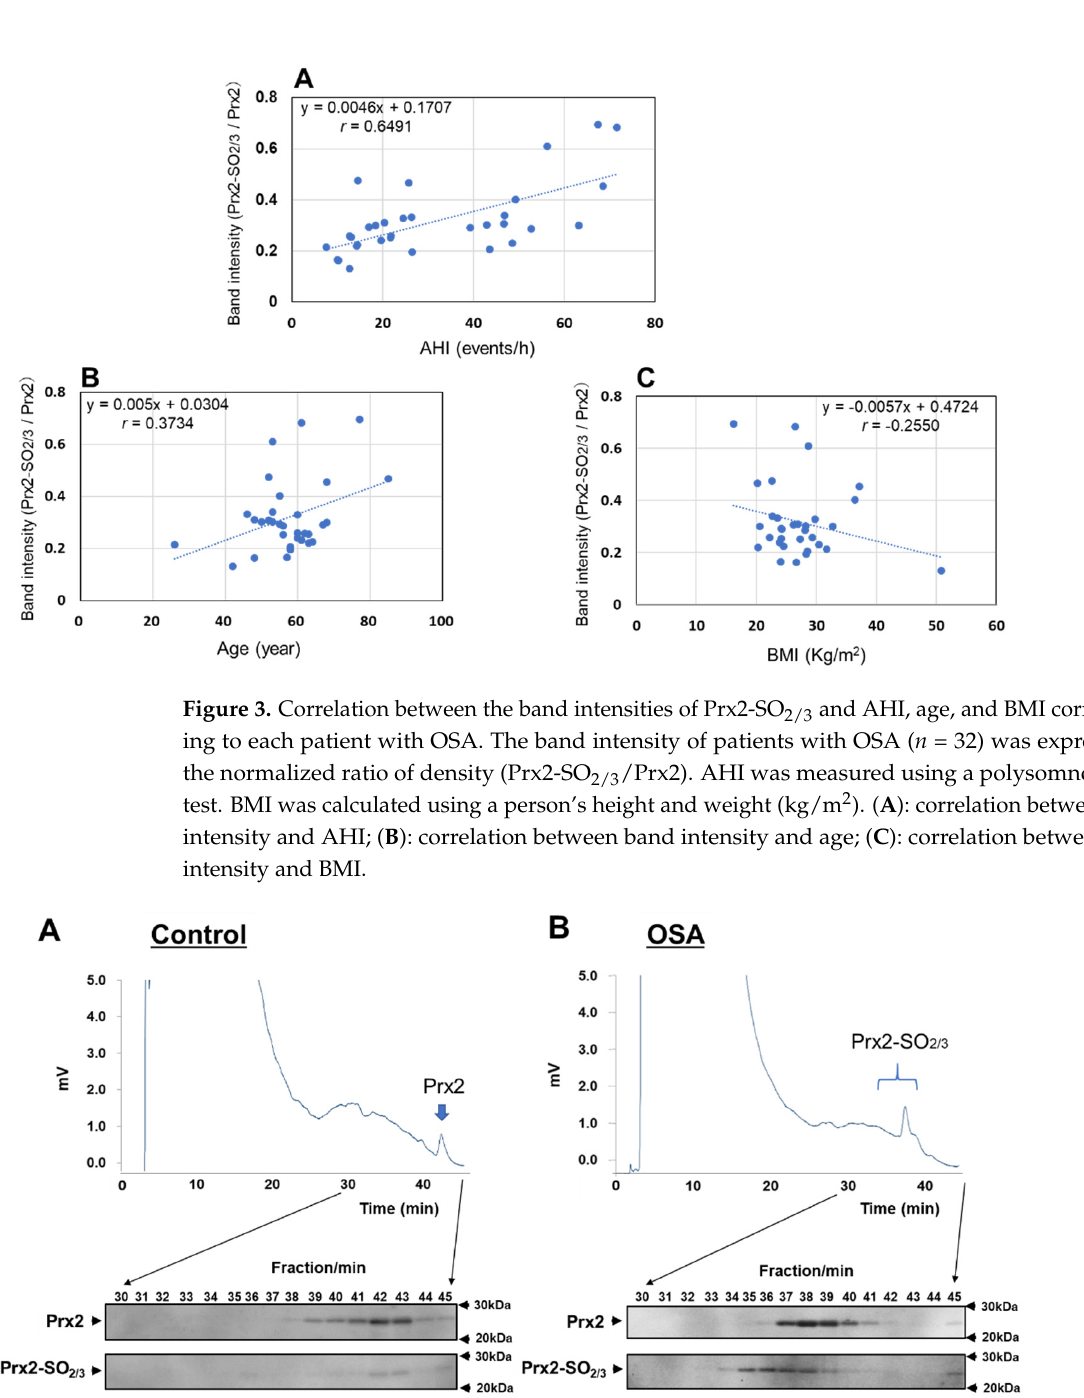
Figure 2. Beeswarm plots for band intensities (Prx2-SO 2/3 /Prx2) of healthy subjects and OSA patients. The densities of Prx2-SO 2/3 bands were measured and normalized to that of Prx2. The band intensity of patients with OSA ( n = 32) and healthy control subjects ( n = 32) was expressed as the normalized ratio of density (Prx2-SO 2/3 /Prx2). *** p < 0.001 versus control group.